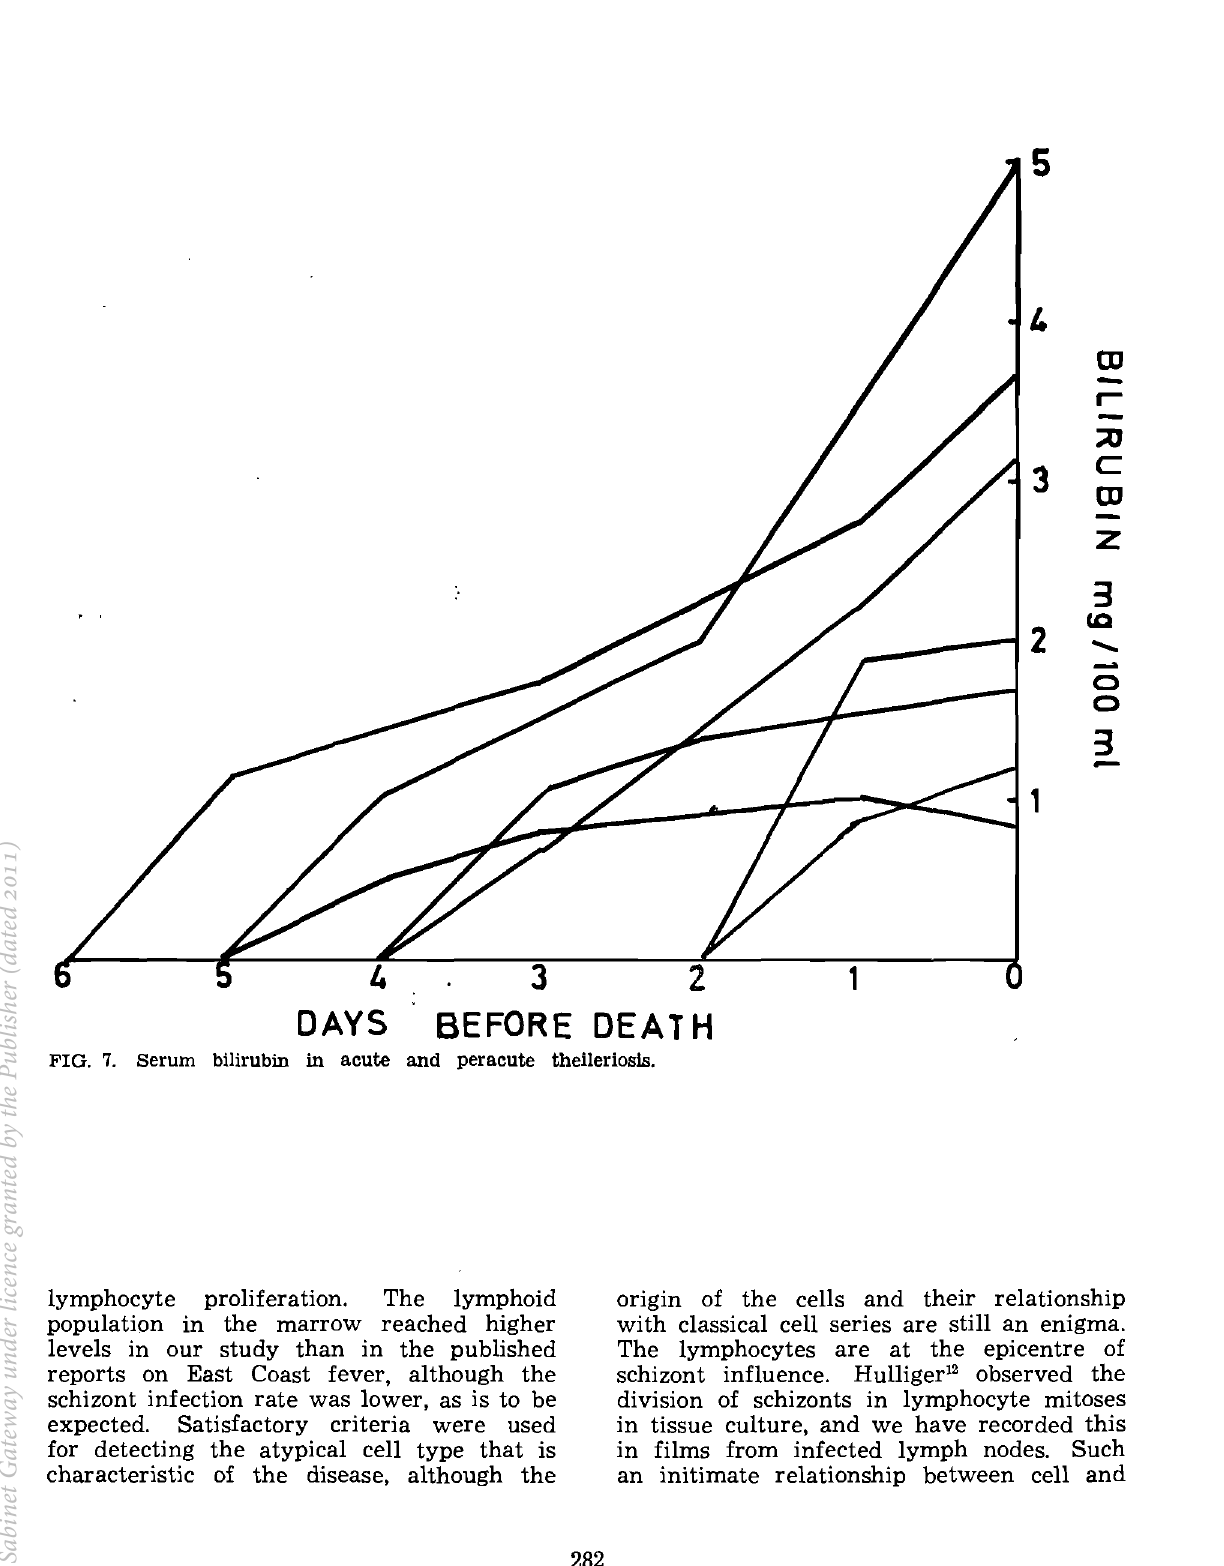
FIG. 7. Serum bilirubin in acute and peracute theileriosiB.